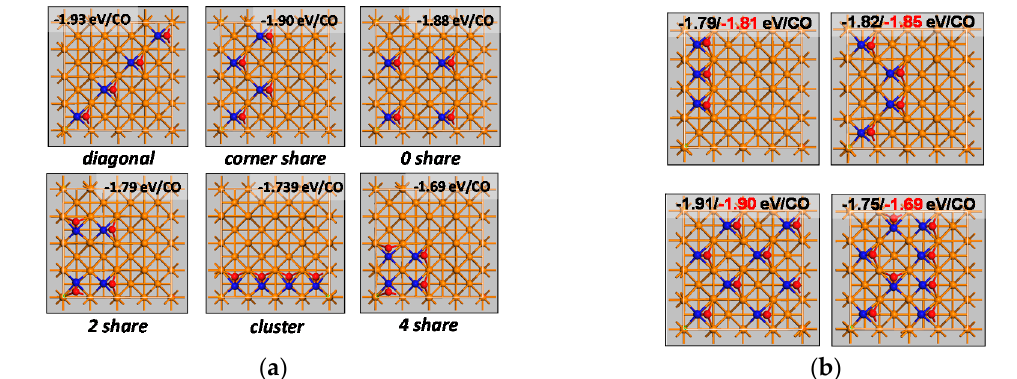
Figure 1. CO adsorption on p(4x4)-Fe(100): ( a ) Θ CO = 0.25 ML in different configurations and their adsorption energy (details given in Table 1), ( b ) Testing the empirical relationship (see text) to determine the adsorption energy in various configurations at Θ CO = 3/16 ML, 0.25 ML and 0.5 ML (black: empirically determined adsorption energy, red: DFT determined adsorption energy).